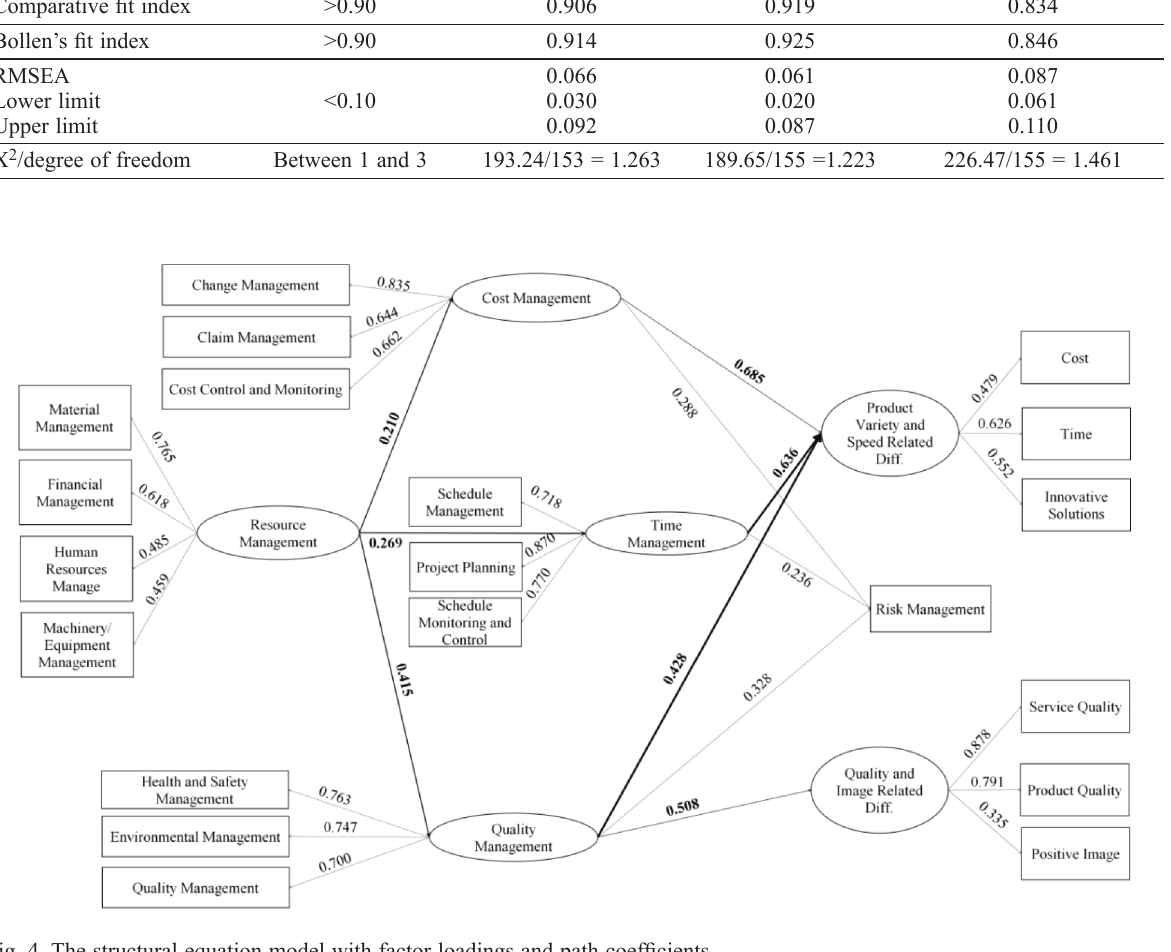
Fig. 4. The structural equation model with factor loadings and path